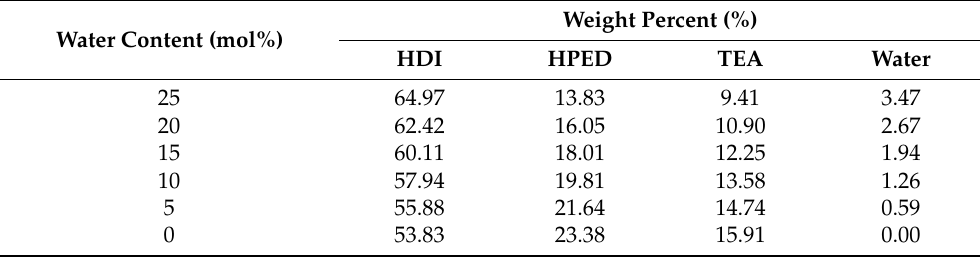
Table 1. Weight percentage (%) of monomers and additives used during foam synthesis. Weight Percent (%) Water Content (mol%) HDI